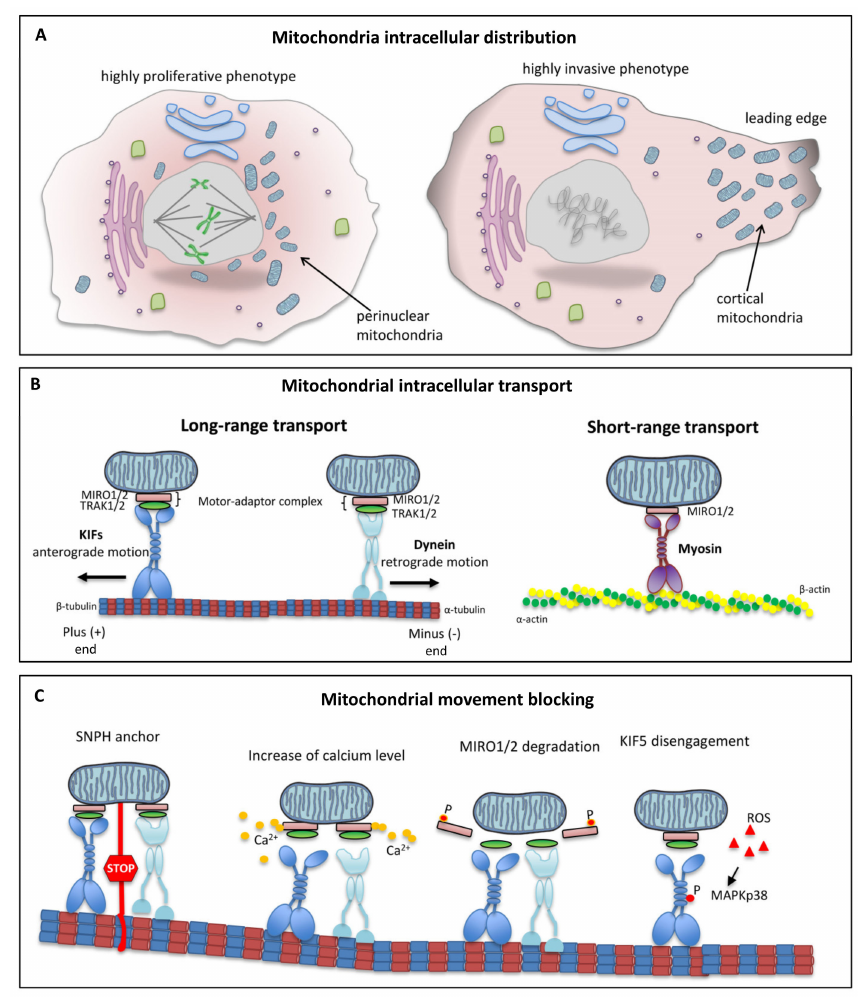
Figure 4. Intracellular mitochondrial trafficking: ( A ) Mitochondrial intracellular distribution. In cancer cells, the presence of abundant perinuclear mitochondria characterizes a highly proliferative phenotype; mitochondrial localization to the leading edge determines a highly invasive phenotype. ( B ) Mitochondrial intracellular transport. Mitochondria move within the cell over short and long distances. Microtubule-based mechanisms drive long-distance transport, while short-distance trans- port is driven by actin-based movement. Long-distance transport is performed by two MT-based molecular motors with opposite functions: the kinesin (KIF)-driven anterograde transport, and the dynein-driven retrograde transport. ( C ) Mitochondrial movement blocking. Mitochondria